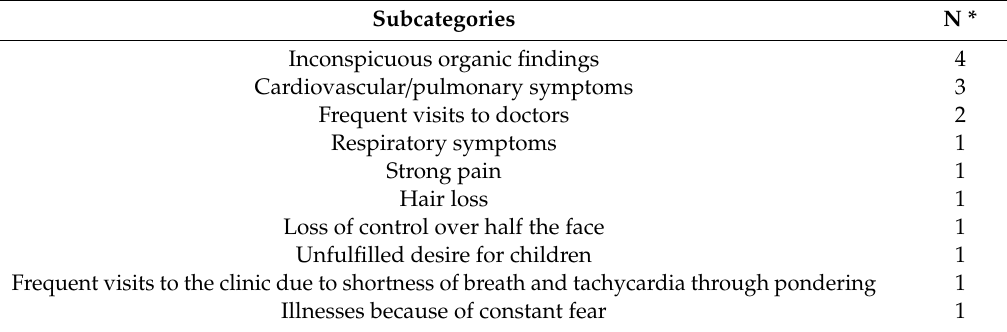
Table 4. Notes on